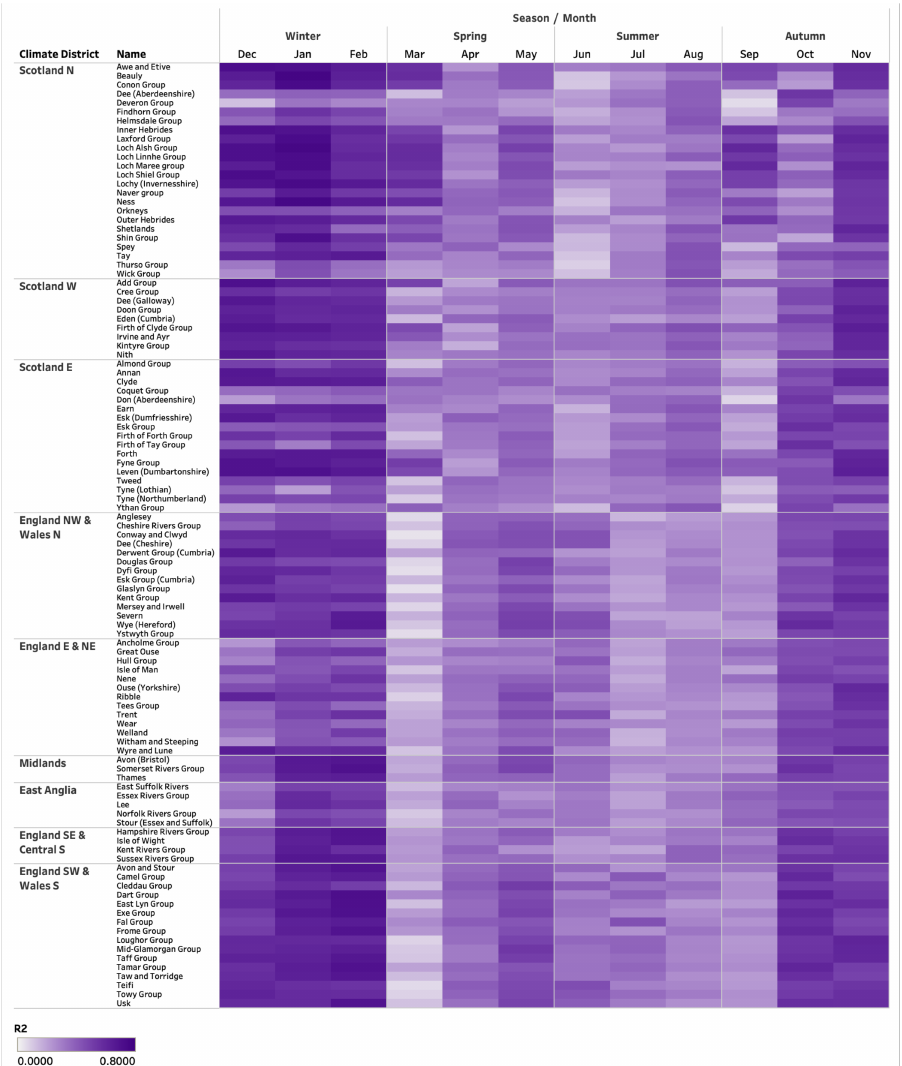
Figure 4. R 2 values of the multivariate regression model exploring the relationship between a combi- nation of all five circulation indices and SPI-1 values across the IHU